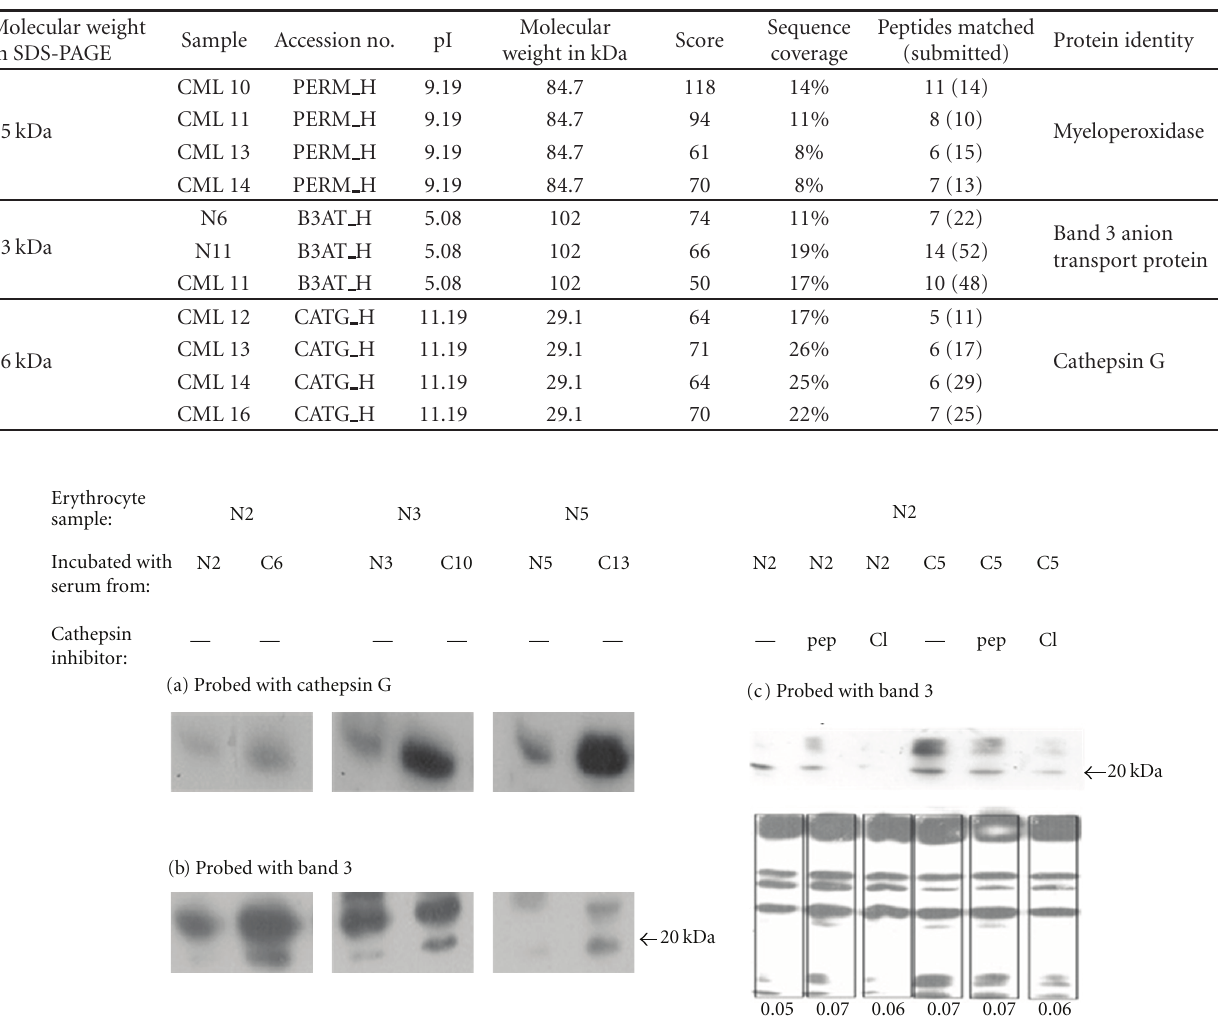
Table 1: Mass spectrometric identification of erythrocyte membrane antigens recognized by serum IgG. Trypsin digests of protein spots in gels of erythrocyte membranes, at a position corresponding to signals for immunogens recognized by serum IgG in the western blot of a replicate gel, were subjected to mass spectrometry. Peptide mass finger print (PMF) data was acquired on the MALDI TOF-TOF Protein analyzer (Ultraflex II, Bruker Daltonics) in the reflector mode. The data was searched against SwissProt database using MASCOT search engine with a peptide mass tolerance of 100ppm.